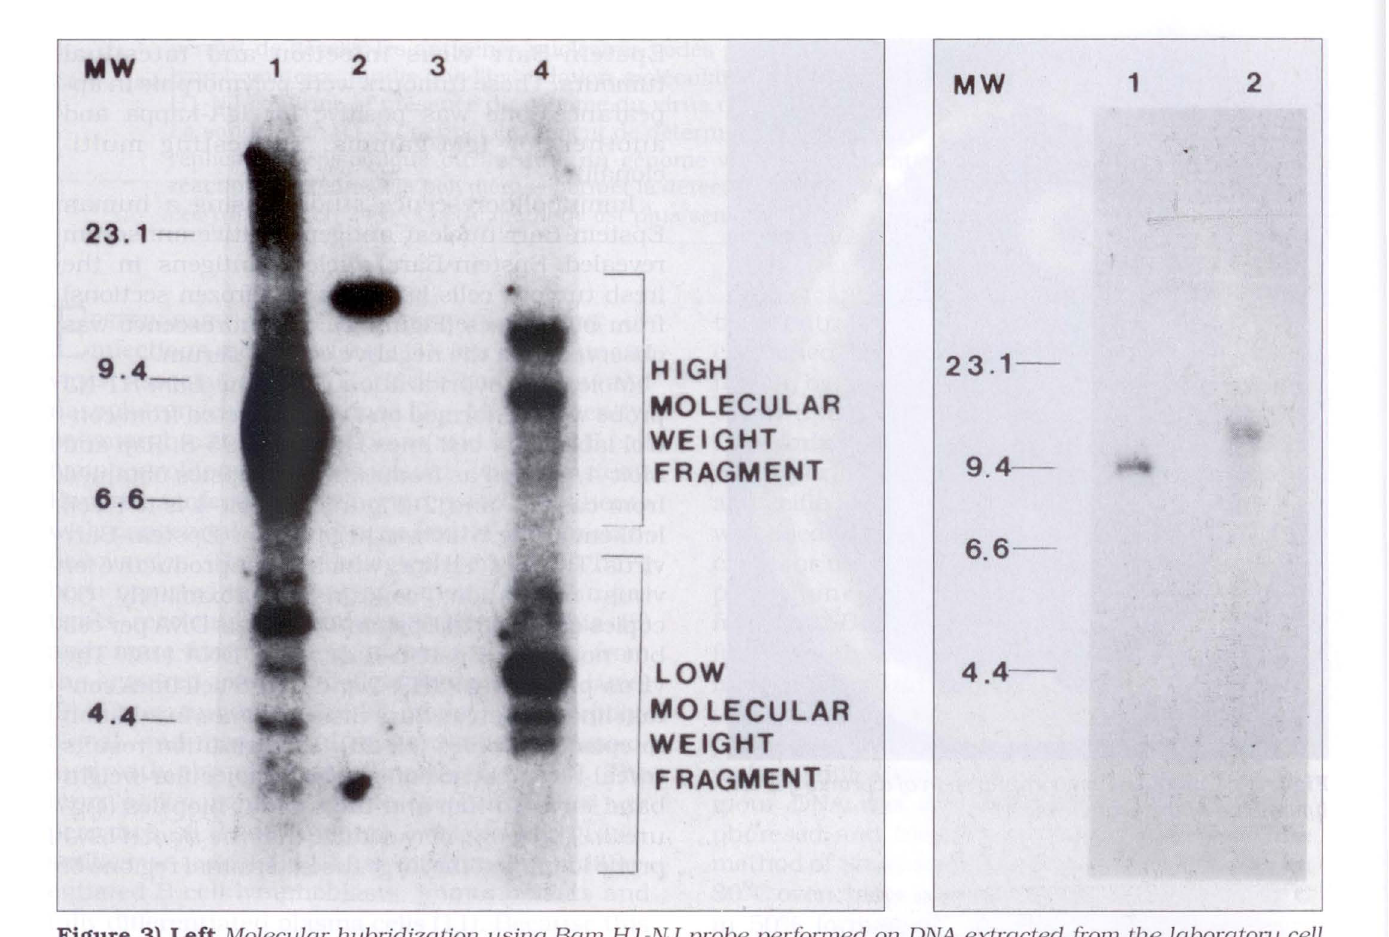
Figure 3) Left Molecular hybridization using Bam Hl-NJ probe performed on DNA ext.raciedfrom the laboratory cell line B95-8 (1). Raji (2). Molt-4 (3) and P3HR1 (4). Right Molecular hybridization using the Bam H 1-NJ probe